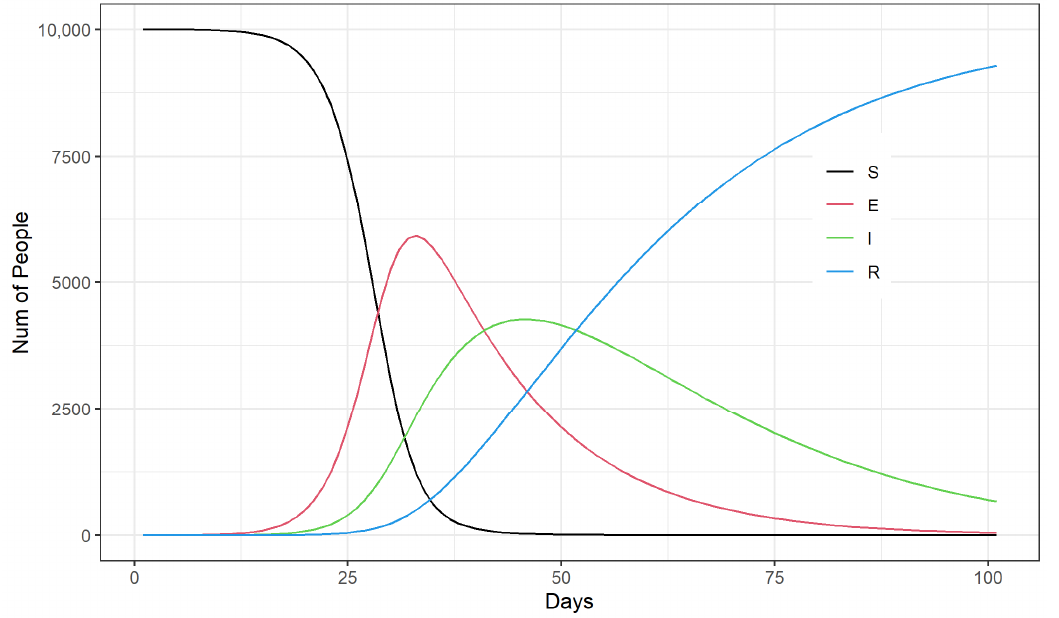
Figure A1. The influence of the daily testing capacity of 0 person on the evolutionary process of the epidemic; (The unit of the ordinate is “person”).